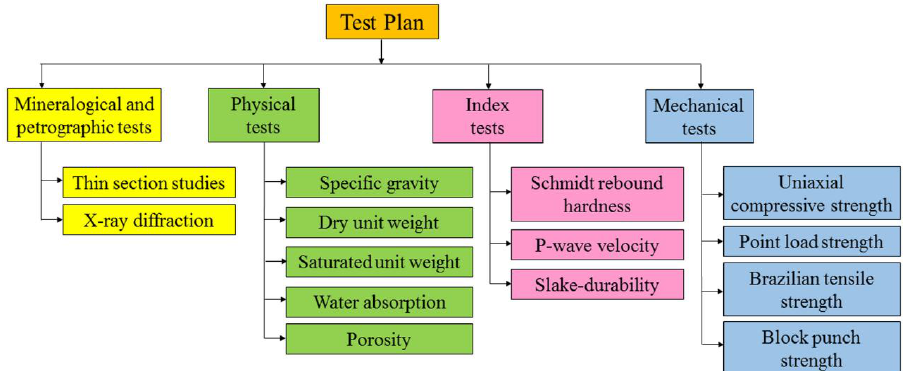
Figure 2. Test plan in this study for determining different properties of the rocks.